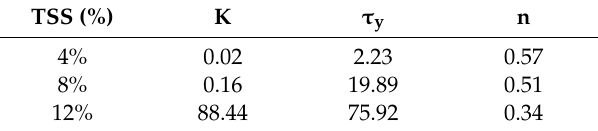
Table 1. The values of consistency index (K), yield stress ( τ y ) and power-law index (n) TSS (%)